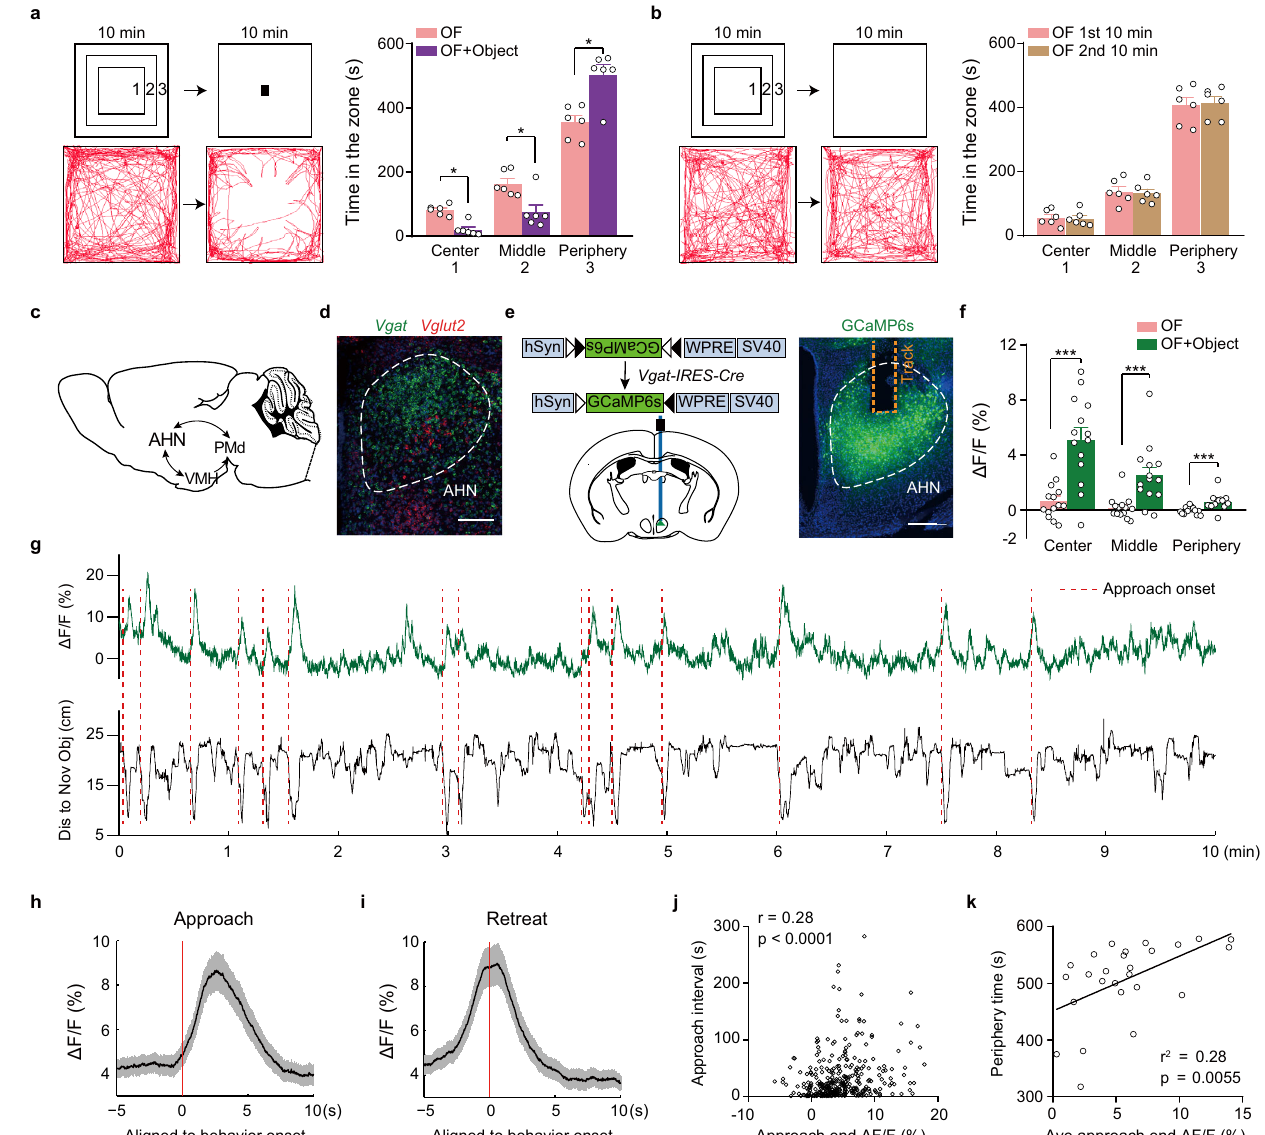
Fig. 1 | Strong temporal correlation of AHN Vgat+ neuron activity with object- evoked avoidance behavior in a modi fi ed open fi eld paradigm. a We modi fi ed the open fi eld test with the introduction of an unfamiliar object 10min after the initial exploration. “ 1 ” , “ 2 ” , and “ 3 ” denote the “ center ” , “ middle ” , and “ peripheral ” zone of the open fi eld. The example trajectory (bottom) and the quanti fi cation (right) show that animals spent more time in the peripheral zone away from the center after object introduction. n =6 mice. Wilcoxon matched-pairs signed rank test, center, p =0.03, middle, p =0.03, peripheral, p =0.03. b In control assays, animals were allowed to explore the open fi eld for 20min. The example trajectory and the quanti fi cation (right) show similar time spent in all three zones in the fi rst and second 10min of the open fi eld test. n =6 mice. Two-tailed paired t test. c Schematic illustration of the “ hypothalamus predator defense circuit ” . d A representative image showing the fl uorescent in situ signals of Vgat and Vglut2 mRNA in AHN. Scale bar, 200 μ m. e Left, the strategy to monitor GCaMP6s signals in AHN Vgat+ neurons. Right, a representative image showing restricted GCaMP6s